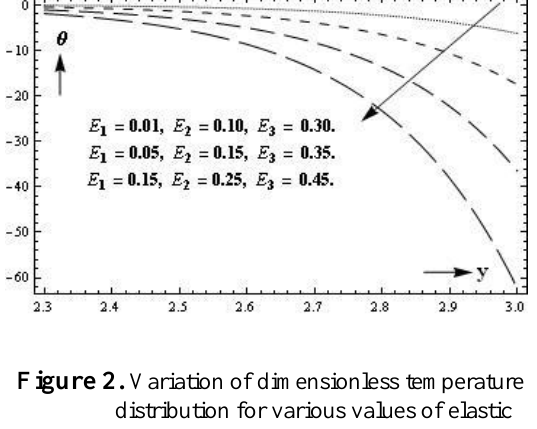
Figure 2. Variation of dimensionless temperature distribution for various values of elastic parameters.